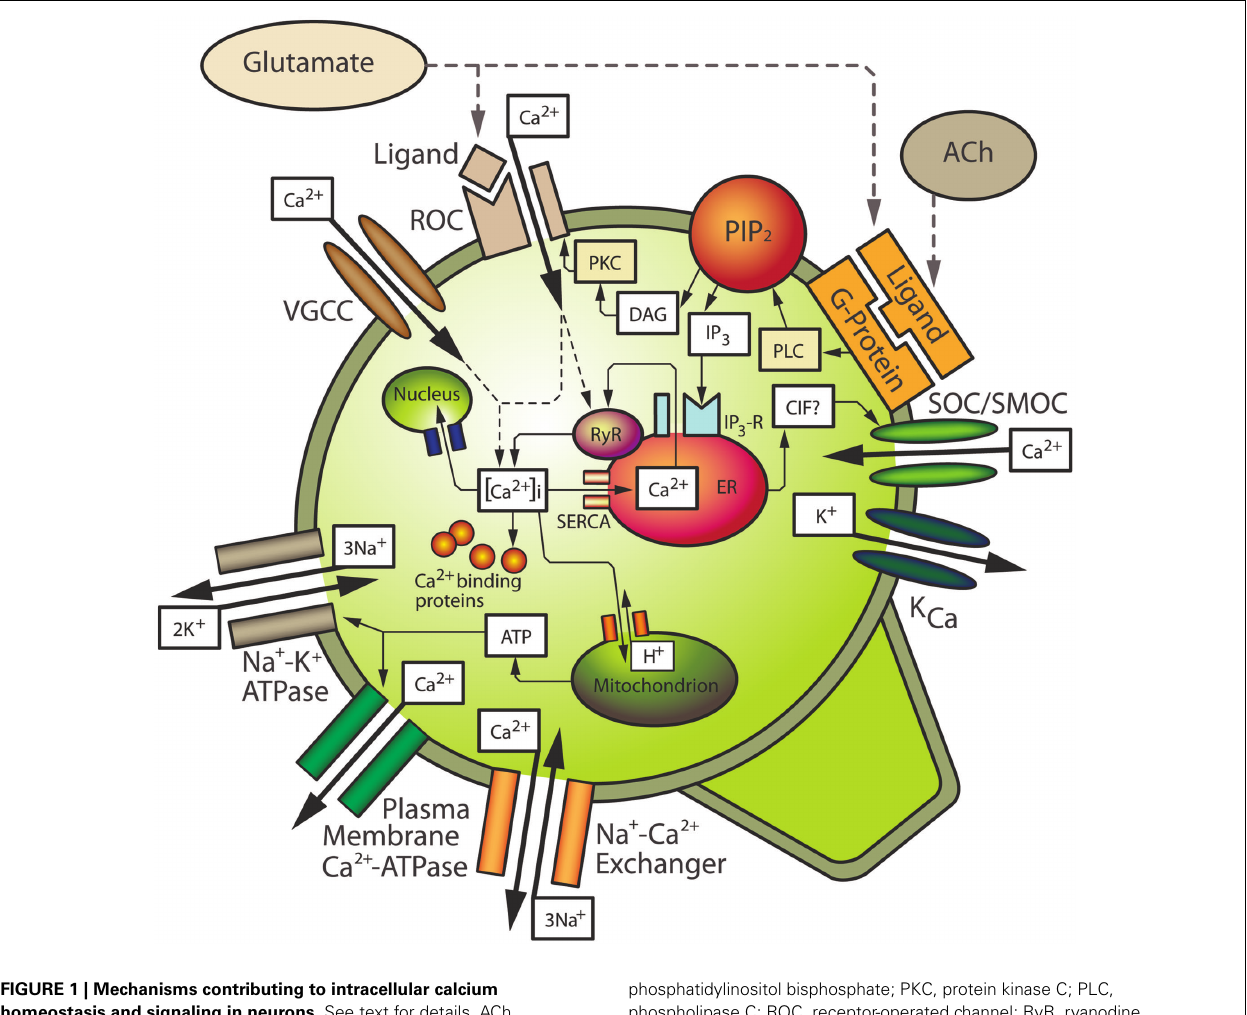
phosphatidylinositol bisphosphate; PKC, protein kinase C; PLC, phospholipase C; ROC, receptor-operated channel; RyR, ryanodine receptor; SERCA, sarcoplasmic–endoplasmic reticulum Ca 2 + -ATPase; SOC/SMOC, store-operated/second messenger-operated channel;VGCC, voltage-gated calcium